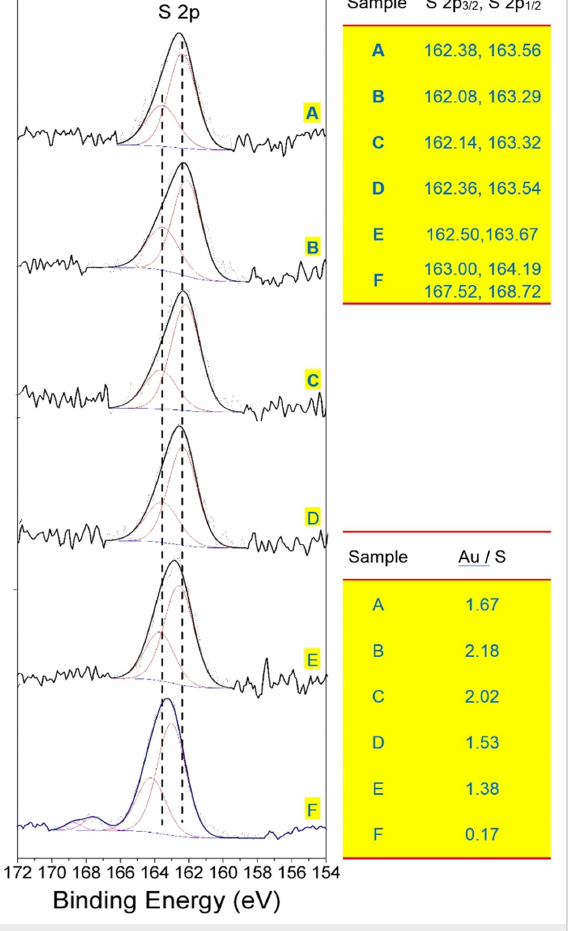
Figure 8: XPS spectra in the S 2p region of the (A) crude penicil- lamine-protected AuNC product and the sequential size-selected frac- tions (B) F 36% , (C) F 54% , (D) F 72% , (E) F 90% , and (F) F 0% . The right panel displays the S 2p 3/2 and S 2p 1/2 binding energies of the sam-